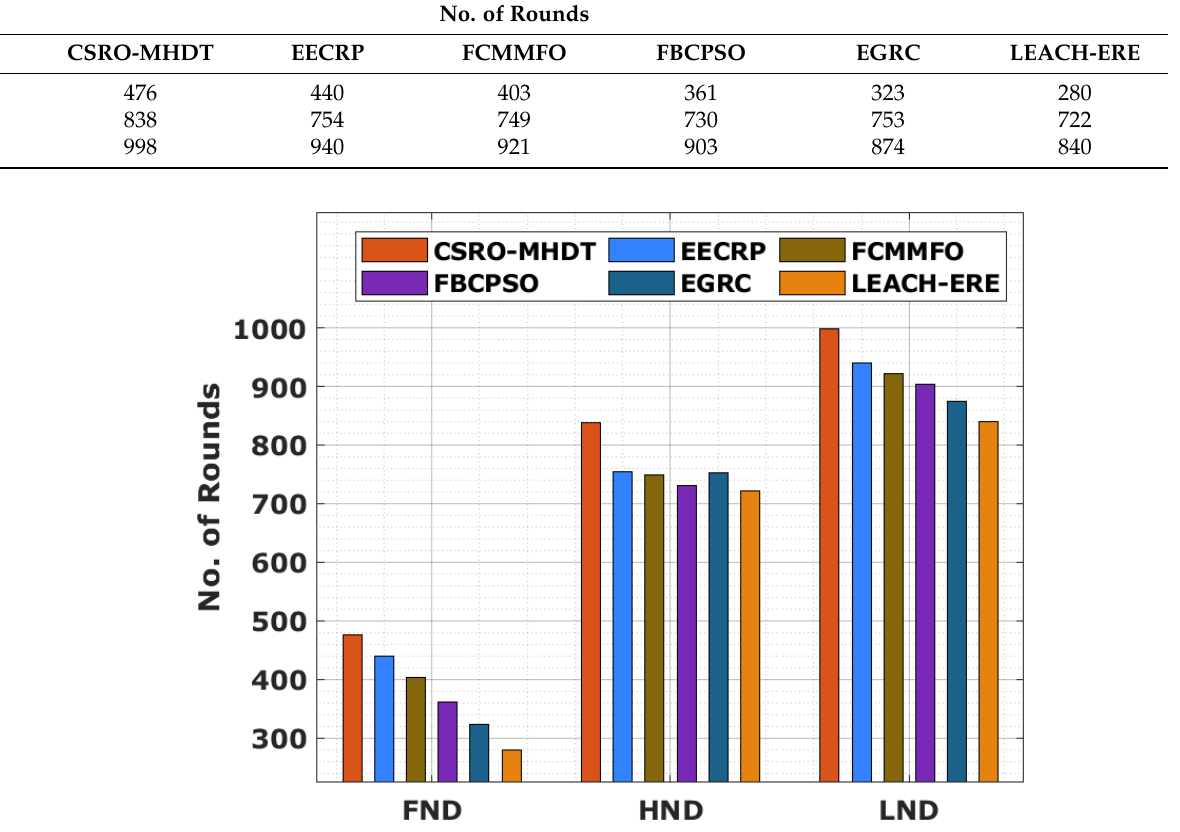
Table 4. TEC analysis of the CSRO-MHDT technique in comparison with existing approaches with different rounds.